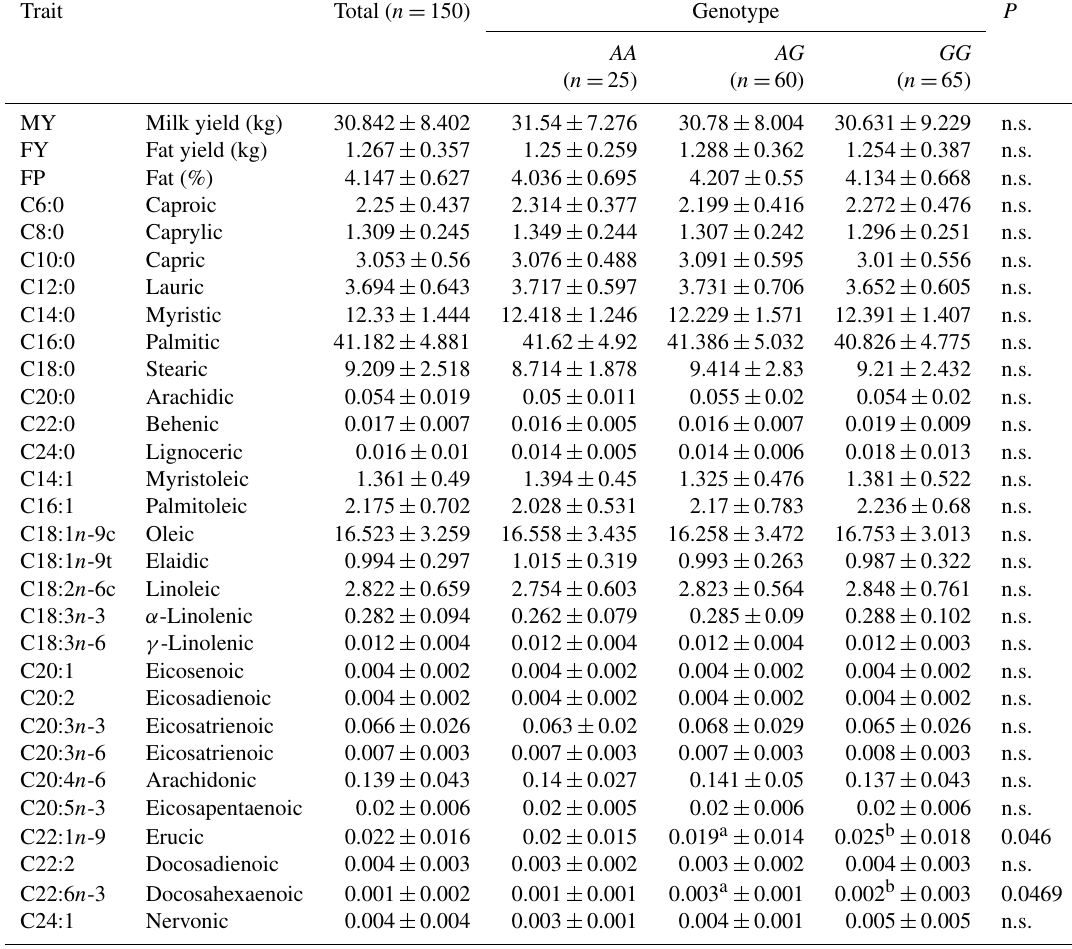
Table 4. The association of FADS2 polymorphism with the fatty acid composition (%) in the milk of Polish Holstein-Friesian cows.